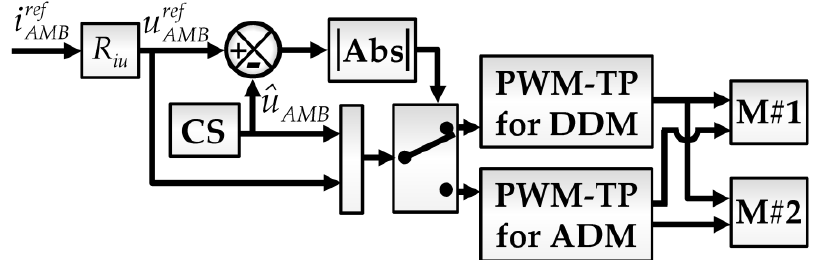
Figure 4. Schematic diagram for two PWM-TPs (pulse width modulation-tuning processors) embedded in DC 2 (dual cooperative drive circuit).